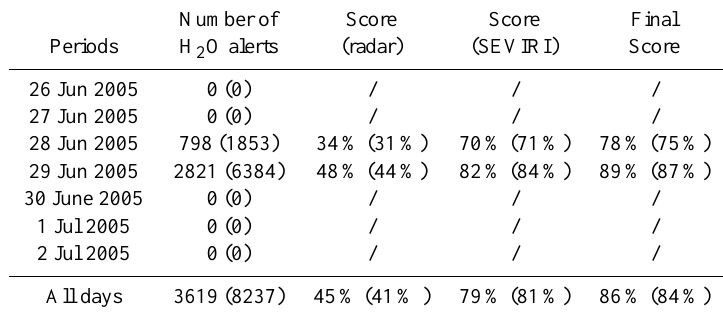
Table 3. Number and score of our H 2 O alert strategy (GNSS observations from 26 June 2005 to 2 July 2005). The time resolution of GNSS observations is 15min. In brackets are shown results when GNSS observations are interpolated linearly every